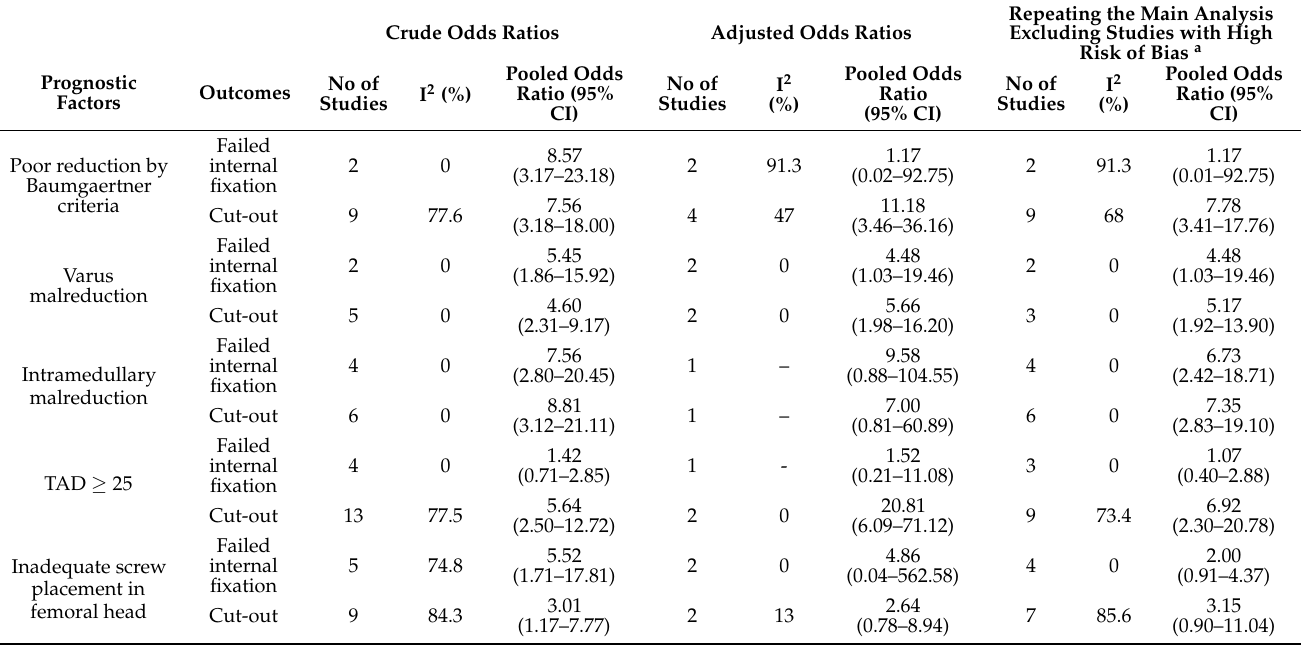
Table 3. Sensitivity analysis on association between immediate postoperative radiographic findings and failed internal